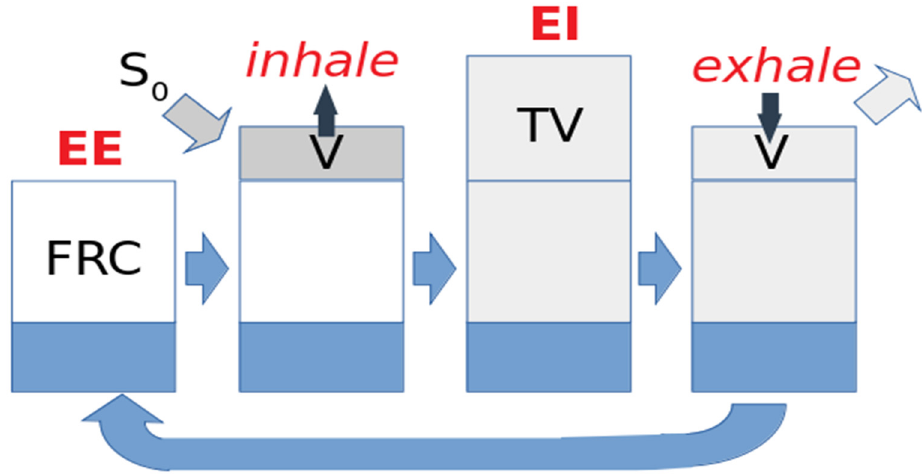
Figure 3. A schematic depiction of gas replacement in a region (voxel) of lung parenchyma. During each breath, a volume of contrast agent gas TV is added to and mixes with the residual gas of volume FRC, and the mixed gas is partially exhaled back to FRC. Note that FRC is less than the voxel volume because with the exception of airways, each voxel contains some tissue. Local gas replacement efficiency can then expressed as the unitless ‘specific’ SV = TV/FRC or ‘fractional’ FV = TV/(TV + FRC) ventilations.